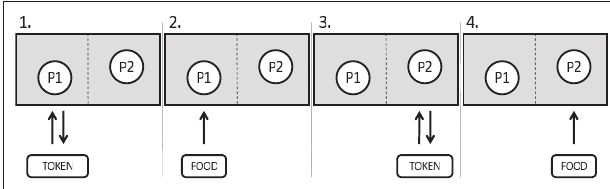
Figure 1 | A schematic diagram indicating the procedure for each trial of an inequity test. Two primates (P1 and P2) are tested in a pair. For each condition (see Table 1 , columns 1 and 2), the primates must sequentially perform a task with the experimenter (typically a token exchange; Table 1 , column 3) in order to receive a food reward ( Table 1 , column 4; see full description of each condition in column 5). An arrow indicates the order in which the object (token or food) moves between the experimenter (E) and the primates in each step of the trial. In all studies in my laboratory, primates are seated side-by-side. Monkeys are separated by a mesh barrier which they can reach through while apes are not separated. The details of the exchange task and the foods given to each primate are determined by the test condition; for details see Table 1